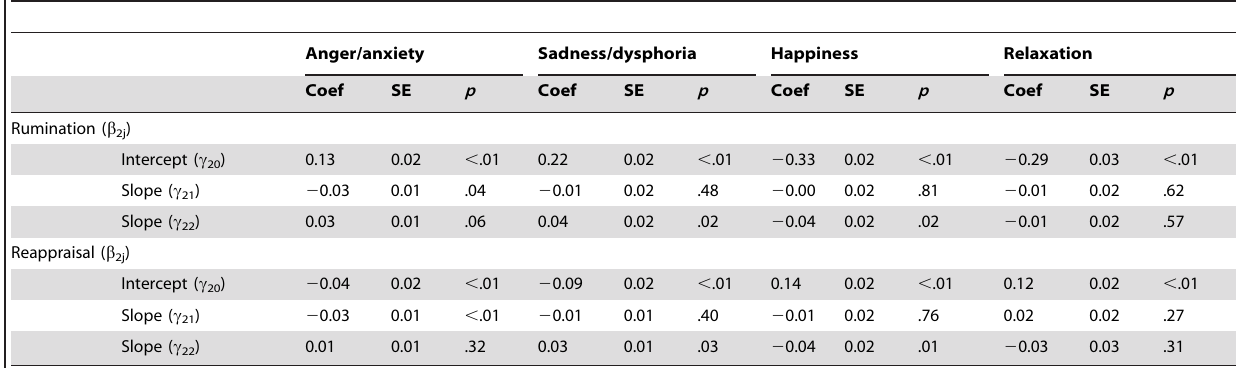
Table 5. Multilevel Analyses on the Moderating Effect of the Emotional n-back on the Relationship between Rumination/ Reappraisal and Emotions in Daily Life after Controlling for Inhibition of Negative